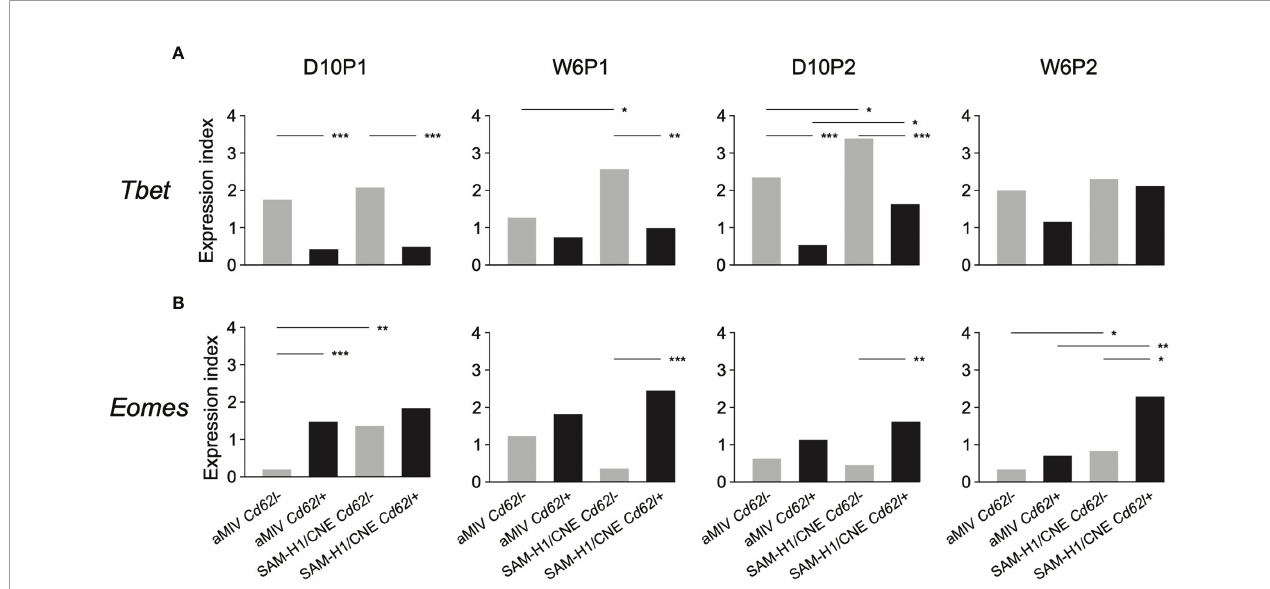
FIGURE 5 | Kinetics of (A) Tbet vs (B) Eomes gene expression in Cd62l- and Cd62l + pent+CD8+ T-cellpopulations. Differences between groups weretested bycomparing the frequencies of cellsexpressing each speci fi c marker through theFisher ’ s exact test. p -values werecorrected for multipletesting using theBenjamini-Hochberg procedure. * p ≤ 0.05, ** p ≤ 0.01, *** p ≤